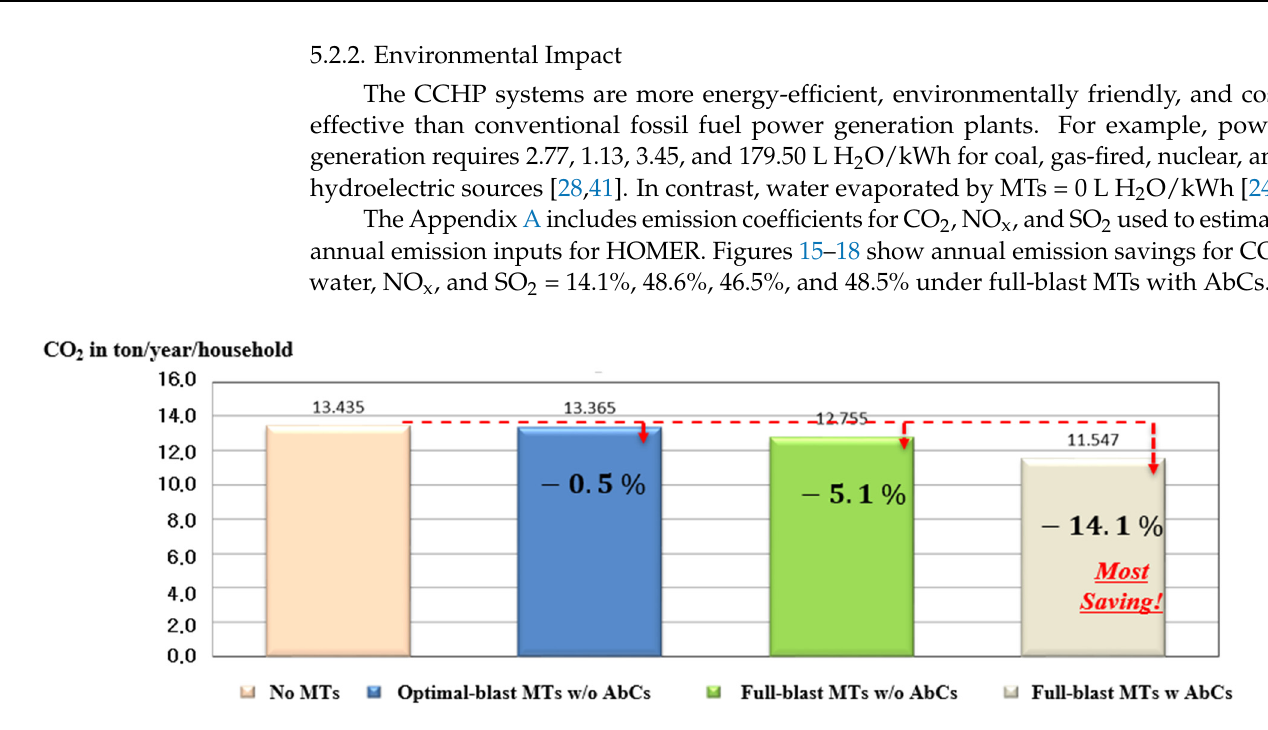
Figure 15. CO 2 emissions savings (scenario 2).